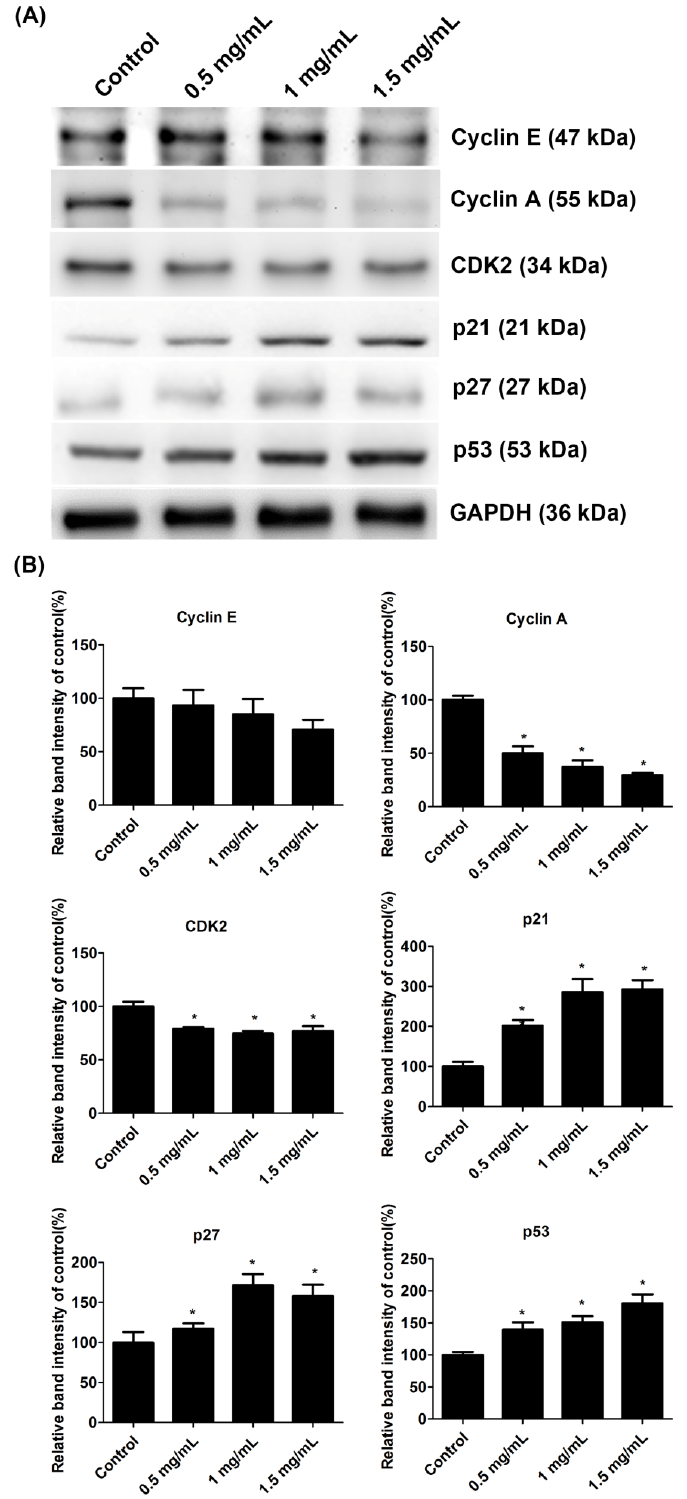
Figure 5. Lidocaine regulated the expression of cell-cycle-associated proteins. ( A ) Western blot analysis of cell cycle–associated proteins. The glyceraldehyde 3-phosphate dehydrogenase (GAPDH) was used as the internal control. ( B ) Densitometric analysis of cyclin E, cyclin A, CDK2, p21, p27, and p53. All data were normalized to GAPDH. Data are presented as the means ± standard errors of the mean of three independent experiments. * p <